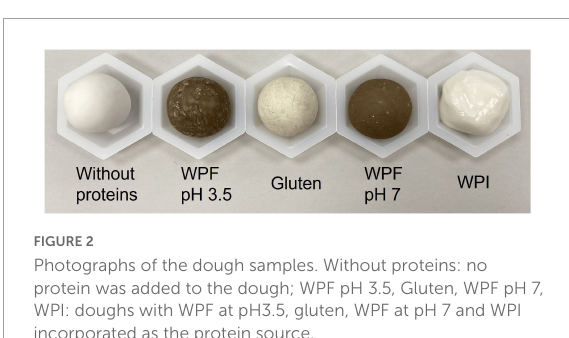
FIGURE2 Photographs of the dough samples. Without proteins: no protein was added to the dough; WPF pH 3.5, Gluten, WPF pH 7, WPI: doughs with WPF at pH3.5, gluten, WPF at pH 7 and WPI incorporated as the protein